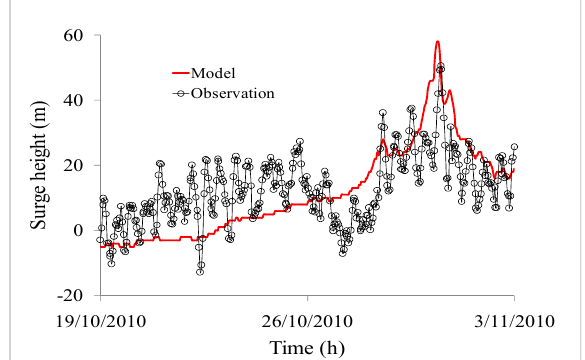
Figure 12. Maximum surge height due to monsoon during 25 October to 3 November 2010.